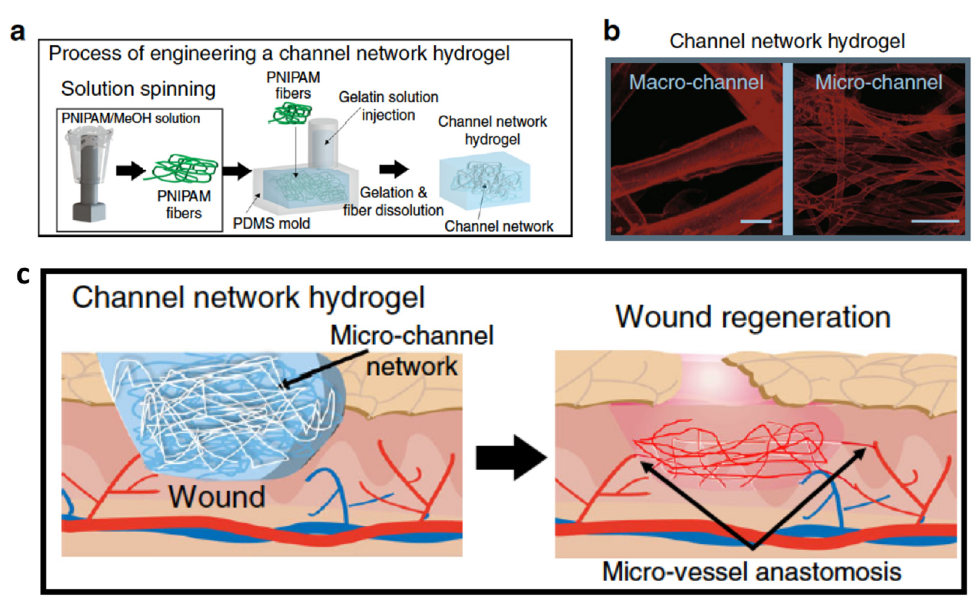
Figure 2. ( a ). Schematic illustration of the procedure to produce poly(Nisopropylacrylamide) (PNIPAM) fibers, then channel networks, in a hydrogel within a PDMS mold. ( b ). Confocal visualization of micro- or microchannel networks in hydrogels with their channel diameter distribution. Channels were perfused with FluoSpheres (45 nm, red). Scale bar = 100 µ m. ( c ). A Schematic illustration of hydrogel implantation into a wound site post-full-thickness defect of mouse dorsal skin with the discovered regeneration process (top box). Photographs of wound healing sites at day 14 post-implantation (bottom row). Reprinted (adapted) with permission from [43] under a Creative Commons Attribution 4.0 International License.